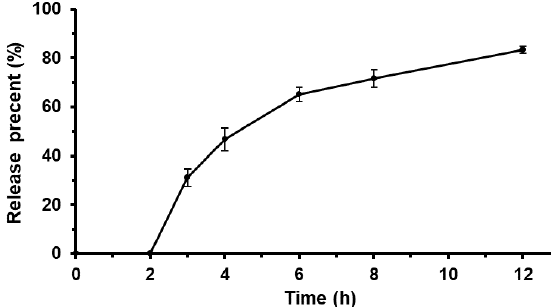
Figure 4. E ff ect of enteric sustained-release pellets on drug release ( n = 3). Figure 4. Effect of enteric sustained-release pellets on drug release ( n = 3).